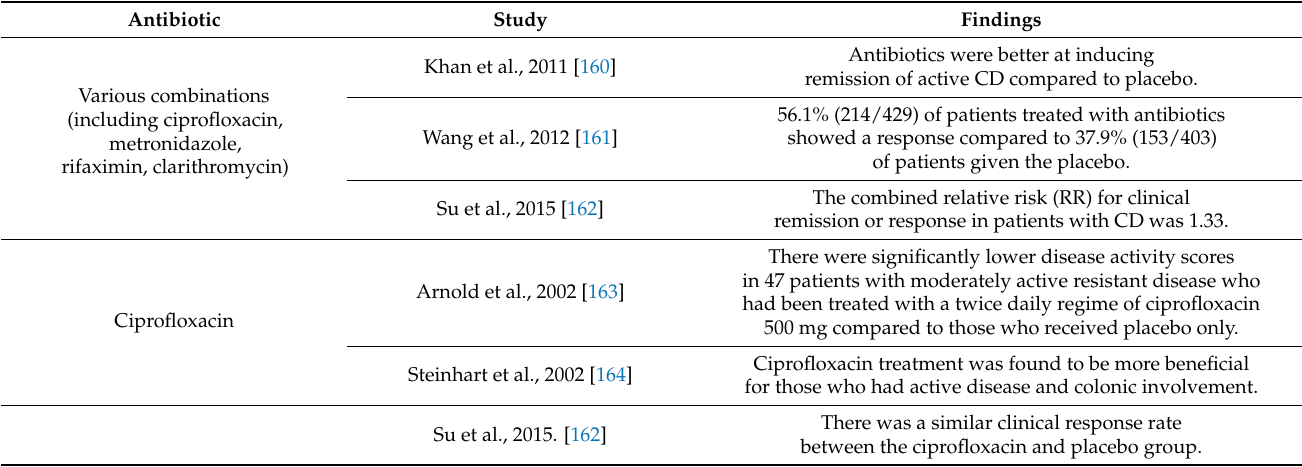
Table 7. Detailing studies assessing the efficacy of antibiotics in active Crohn’s disease. Antibiotic Study